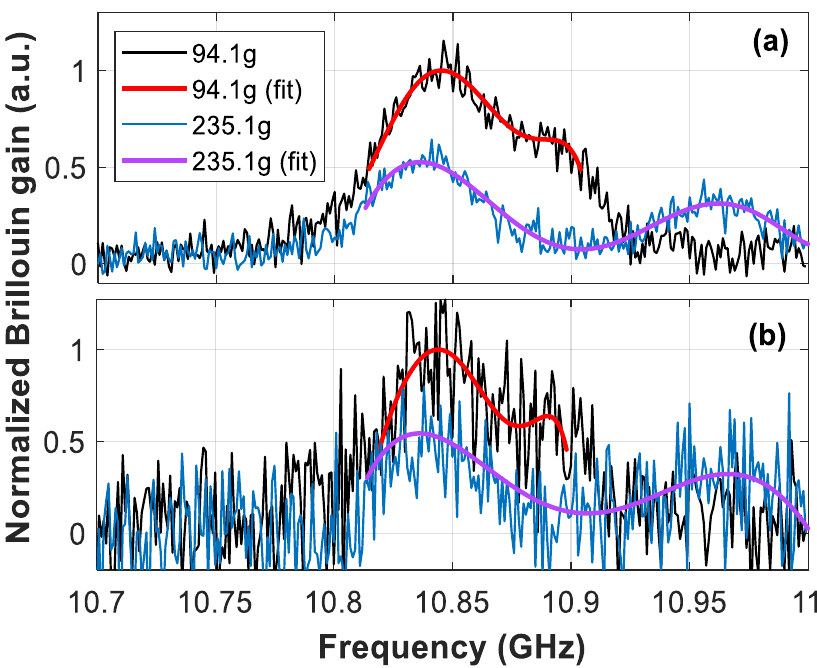
Figure 3. Sixth-order polynomial fitting of two Brillouin spectral measurements at the transition fiber section, obtained by small (94.1 g) and large (235 g) applied strains (masses), for ( a ) 10 dB SNR and ( b ) 5 dB SNR.